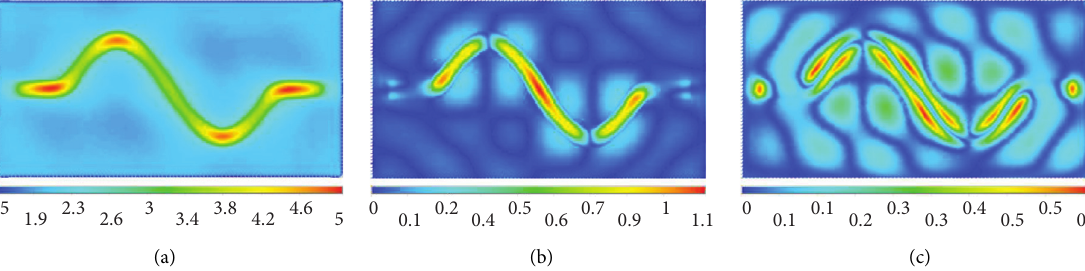
Figure 33: SV wave incident ( H � 150m, f � 1.0Hz, C